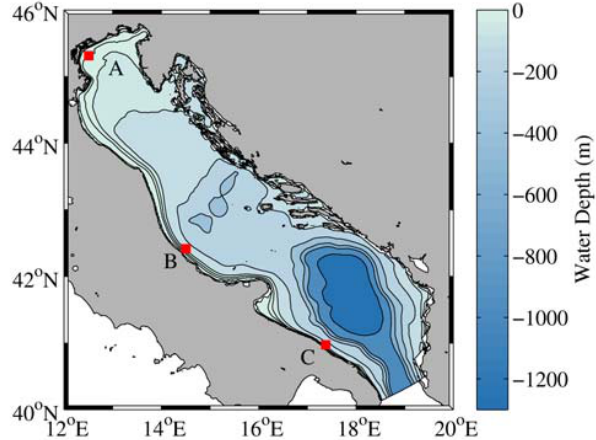
Fig. 2. Map of the Adriatic Sea bathymetry used by the SWAN model. The three markers show the locations used for wave mea- surements. The northern ISMAR-CNR (A) platform, and the central and southern Ortona (B) and Monopoli (C) buoys,